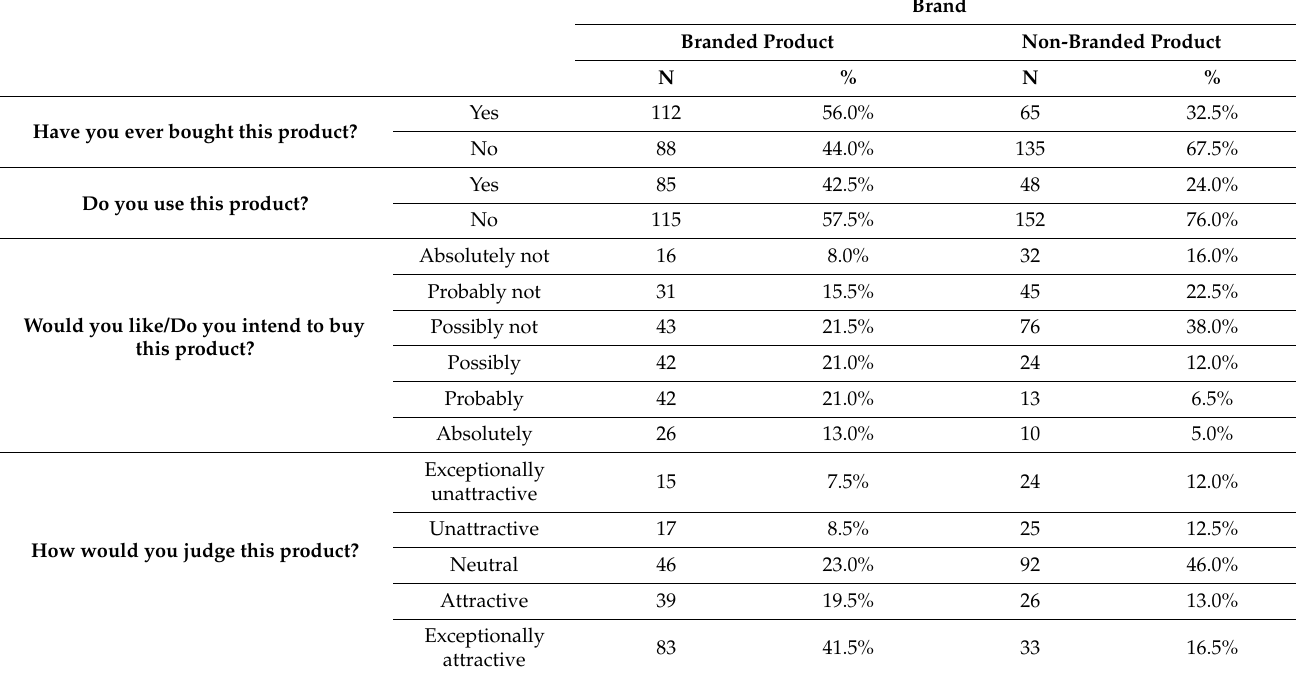
Table 2. Overall behavior and perceptions of consumers towards products based on